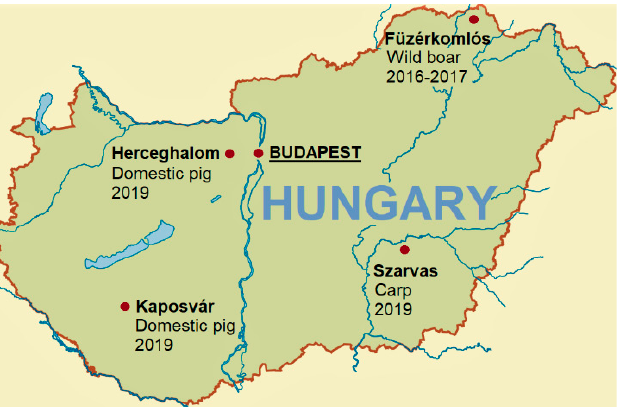
Figure 7. Geographical locations of the sampling sites discussed in this study. Budapest, the capitol, is indicated by underlined letters. The wild boar intestinal content samples collected near Füzérkomlós were examined by shotgun metagenomic sequencing and analyses in a previous study [22].